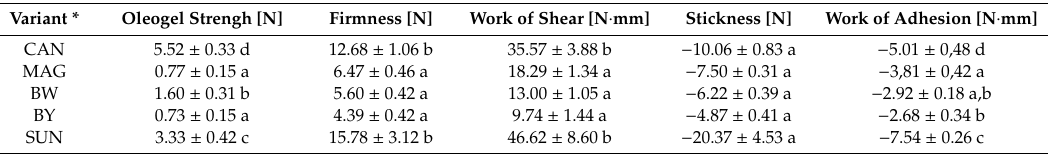
Table 2. The results of oleogel strengh test (first column) and spreadability test of oleogels (firmness, work of shear, stickness, and work of adhesion).